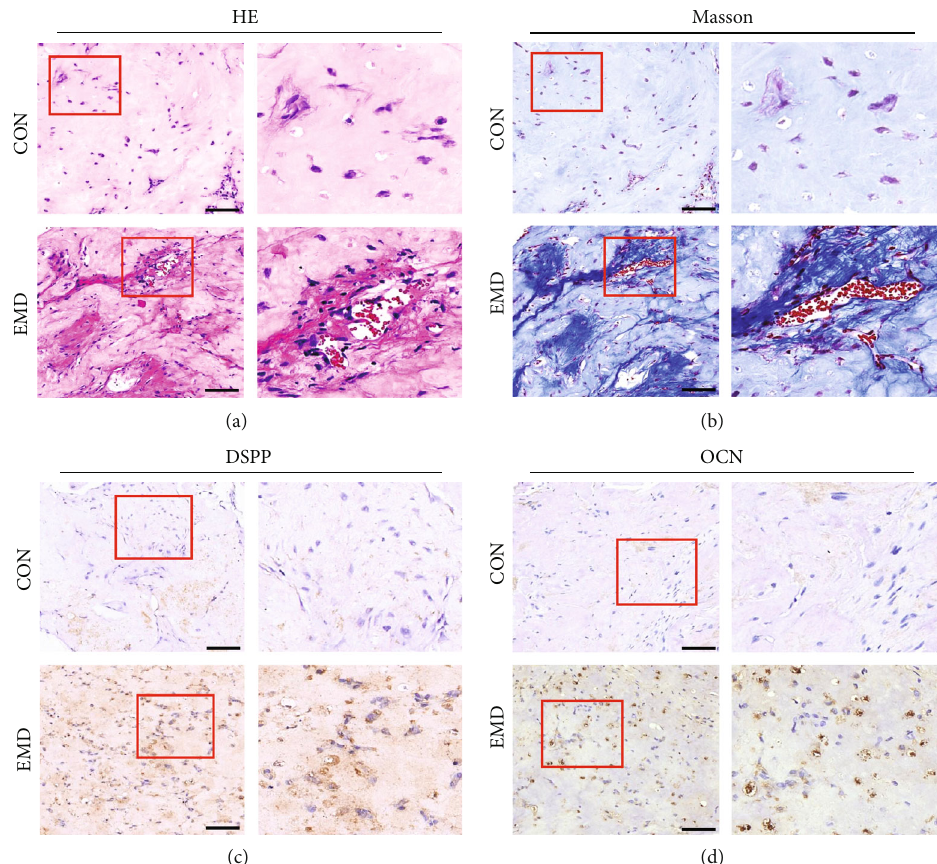
Figure 5: The e ff ect of EMD on DPSCs odontoblastic di ff erentiation and regeneration in vivo . Histological and immunohistochemical analyses of tissue regenerated after ectopic subcutaneous injection for six weeks ( n =8). (a) H&E staining for collagen fi brils (light pink areas) and erythrocytes (bright red). (b) Masson ’ s trichrome staining for collagen matrix (light blue areas), osteoid dentin (dark blue areas), and erythrocytes (bright red). (c) and (d) Immunohistochemical staining of DSPP and OCN, respectively. The dark brown areas in the extracellular matrix indicated positive expression of DSPP and OCN. Red boxed areas were zoomed in and presented on the right side of the corresponding image. Scale bar =100 μ